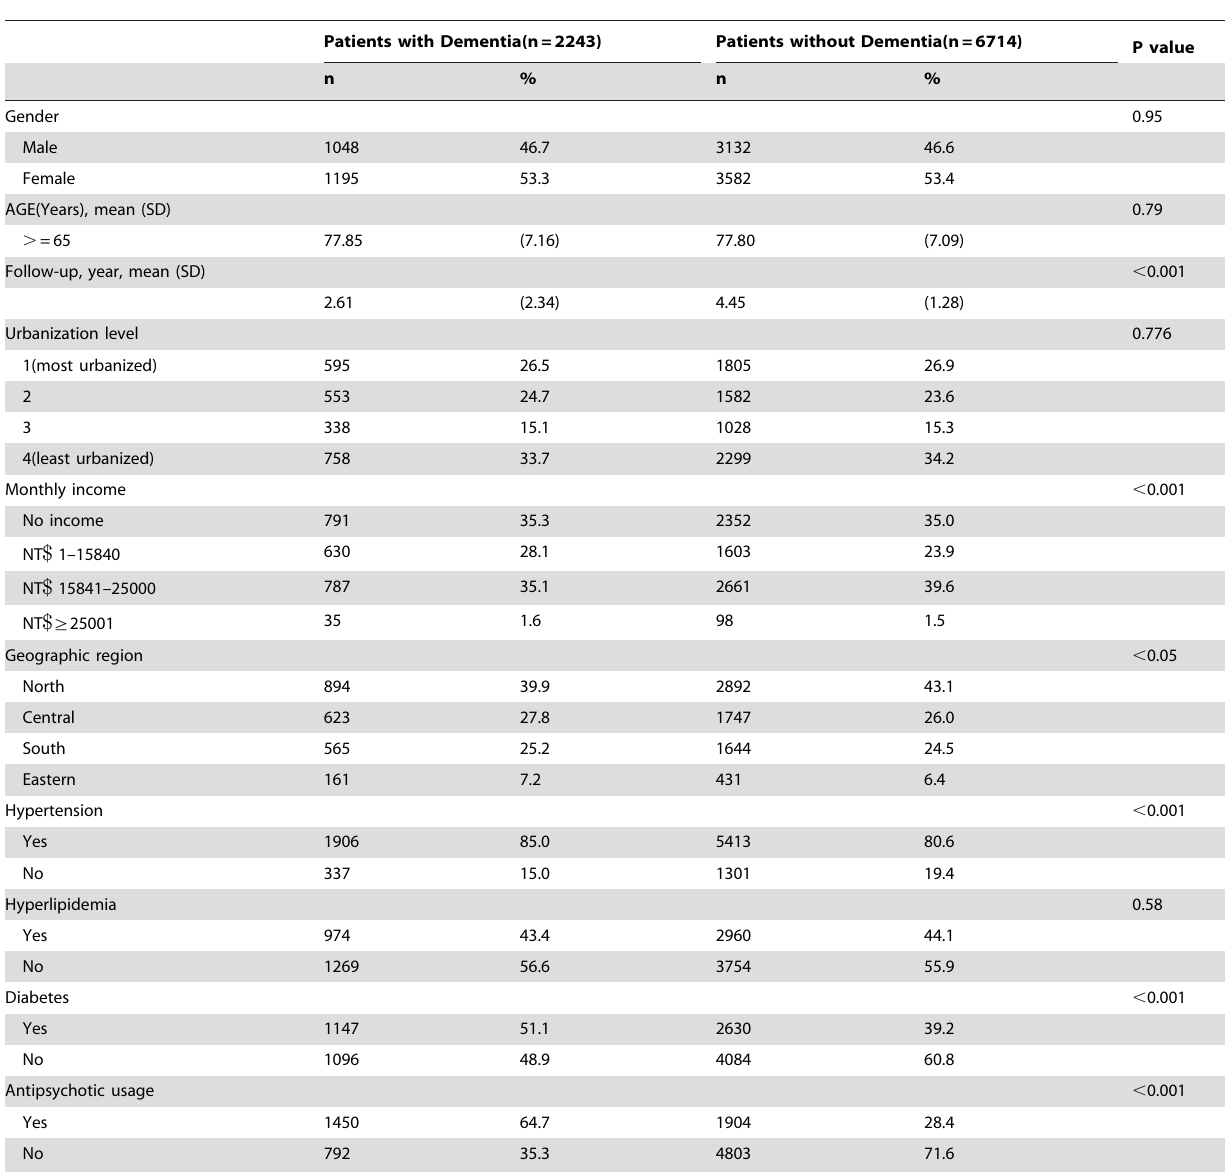
Table 1. Demographic Characteristics for the Selected Elders, Stratified by Presence or Absence of Dementia from 2003 to 2005.